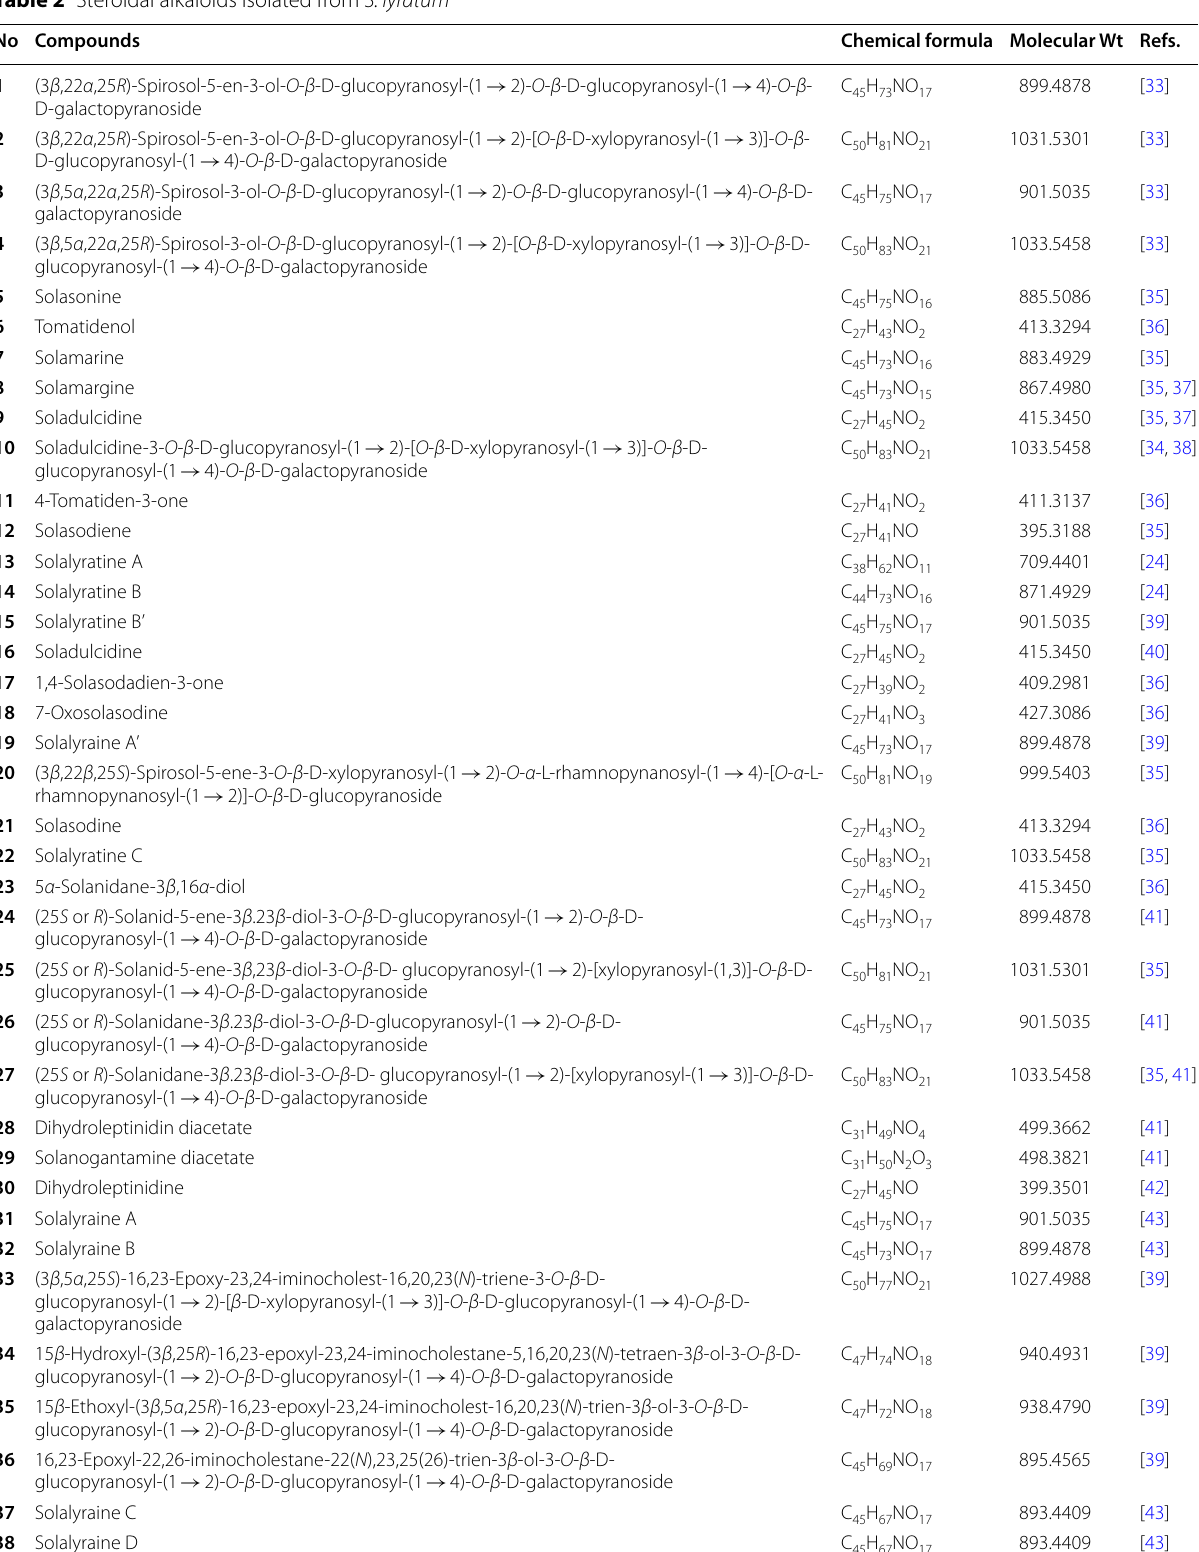
Table 2 Steroidal alkaloids isolated from S. lyratum No Compounds Chemical formula Molecular Wt